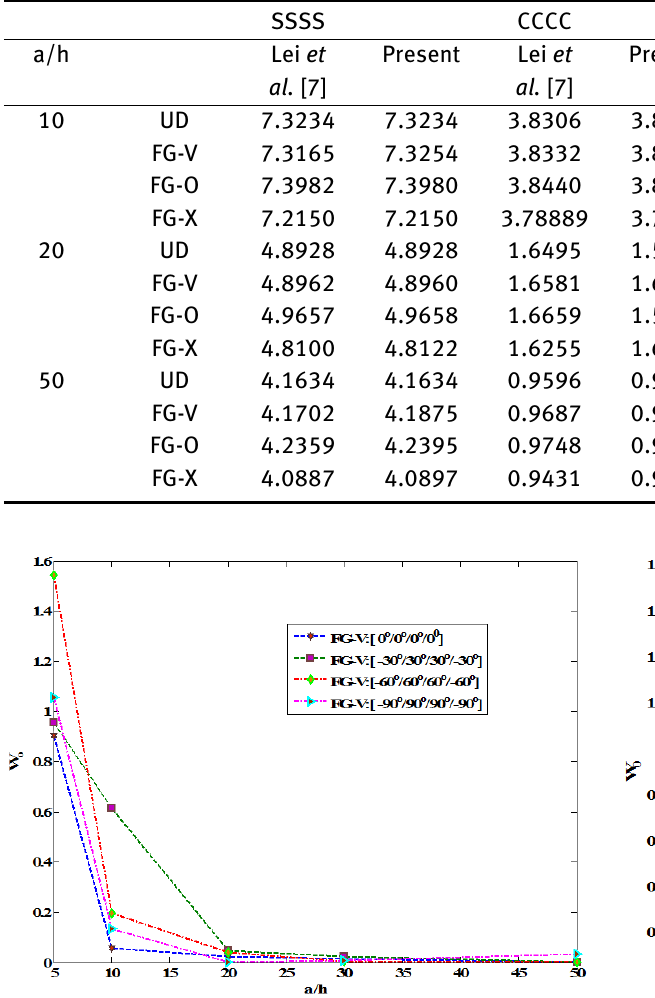
Table 2: Non-dimensional displacement based on aspect ratio (a/h) of validated results from Lei et al. [7]